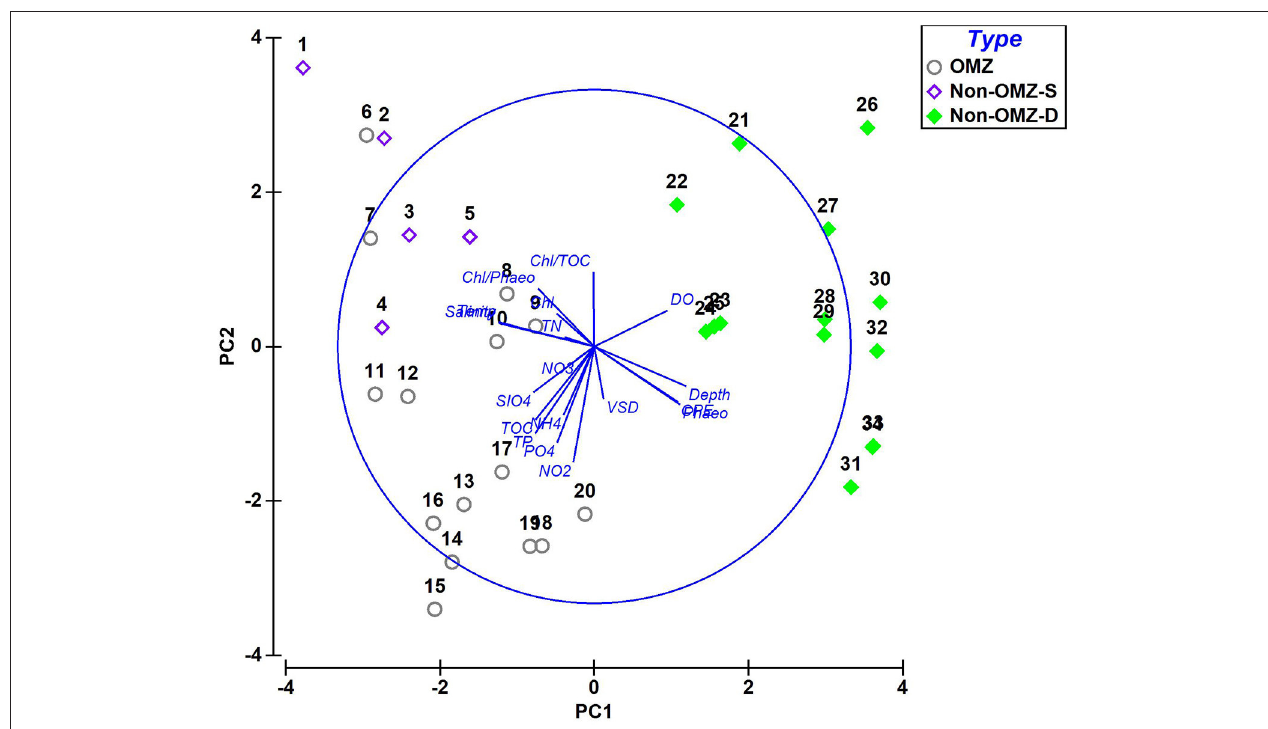
FIGURE 2 | Principal-component analysis (PCA) derived from the contribution of parameters in each benthic zone. PC 1 and 2 accounted for 53.6% of the total variation present. Type: non-OMZ-S – 111m (1–5); OMZ – 202m (6–10), 485m (11–15), 764m (16–20); non-OMZ-D – 1,204m (21–25), 2,054m (26–30), 3,918m (31–34). Numerical codes represent the sequential number of vertical sections such as 1 = 0–2cm, 5 = 8–10cm.